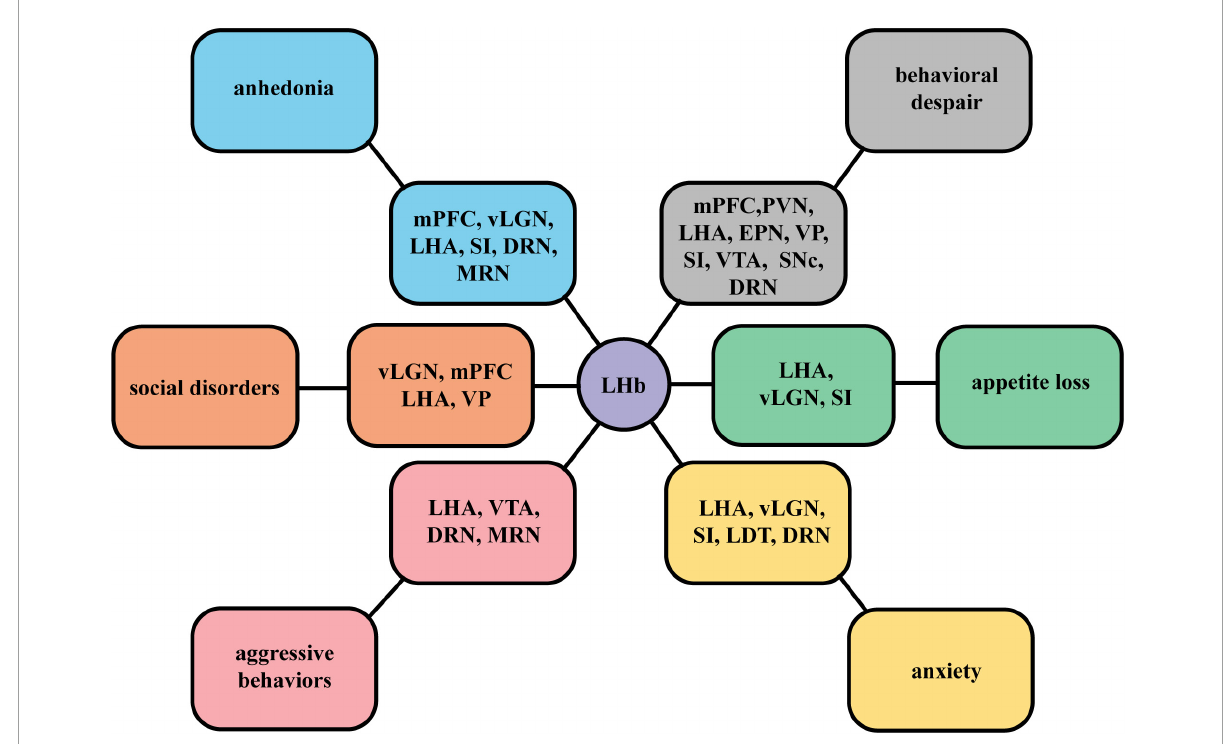
FIGURE4 A summary figure of specific mood symptoms dominated by the LHb in different neural circuits. According to specific behavioral manifestations in studies on LHb circuits, we summarize different mainly depressive symptoms mediated by the neural projections between the LHb and different nuclei, including anhedonia, social disorders, behavioral despair, aggressive behaviors, appetite loss, and